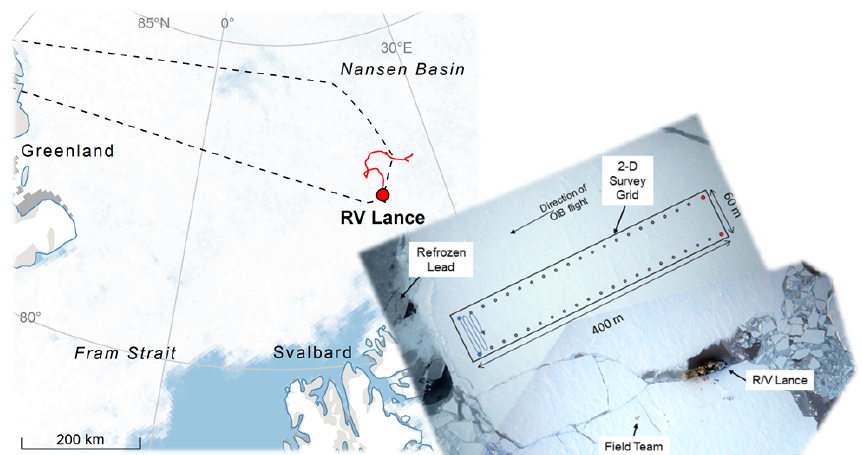
Figure 1. Overview of the location in the Arctic Ocean (left) and setup of the 2-D in situ survey field situated on an ice floe as a part of the Floe 2 drifting phase to the west of R/V Lance on 19 March 2015 (right). Digital mapping system (DMS) imagery (Dominguez, 2010, updated 2018) acquired during the OIB overflights was mosaicked to produce the aerial overview map. Black dots indicate the outline of the 2-D survey field. Snow and ice thickness measurements were obtained along the snake-line sampling pattern, as indicated in the left of the survey field.